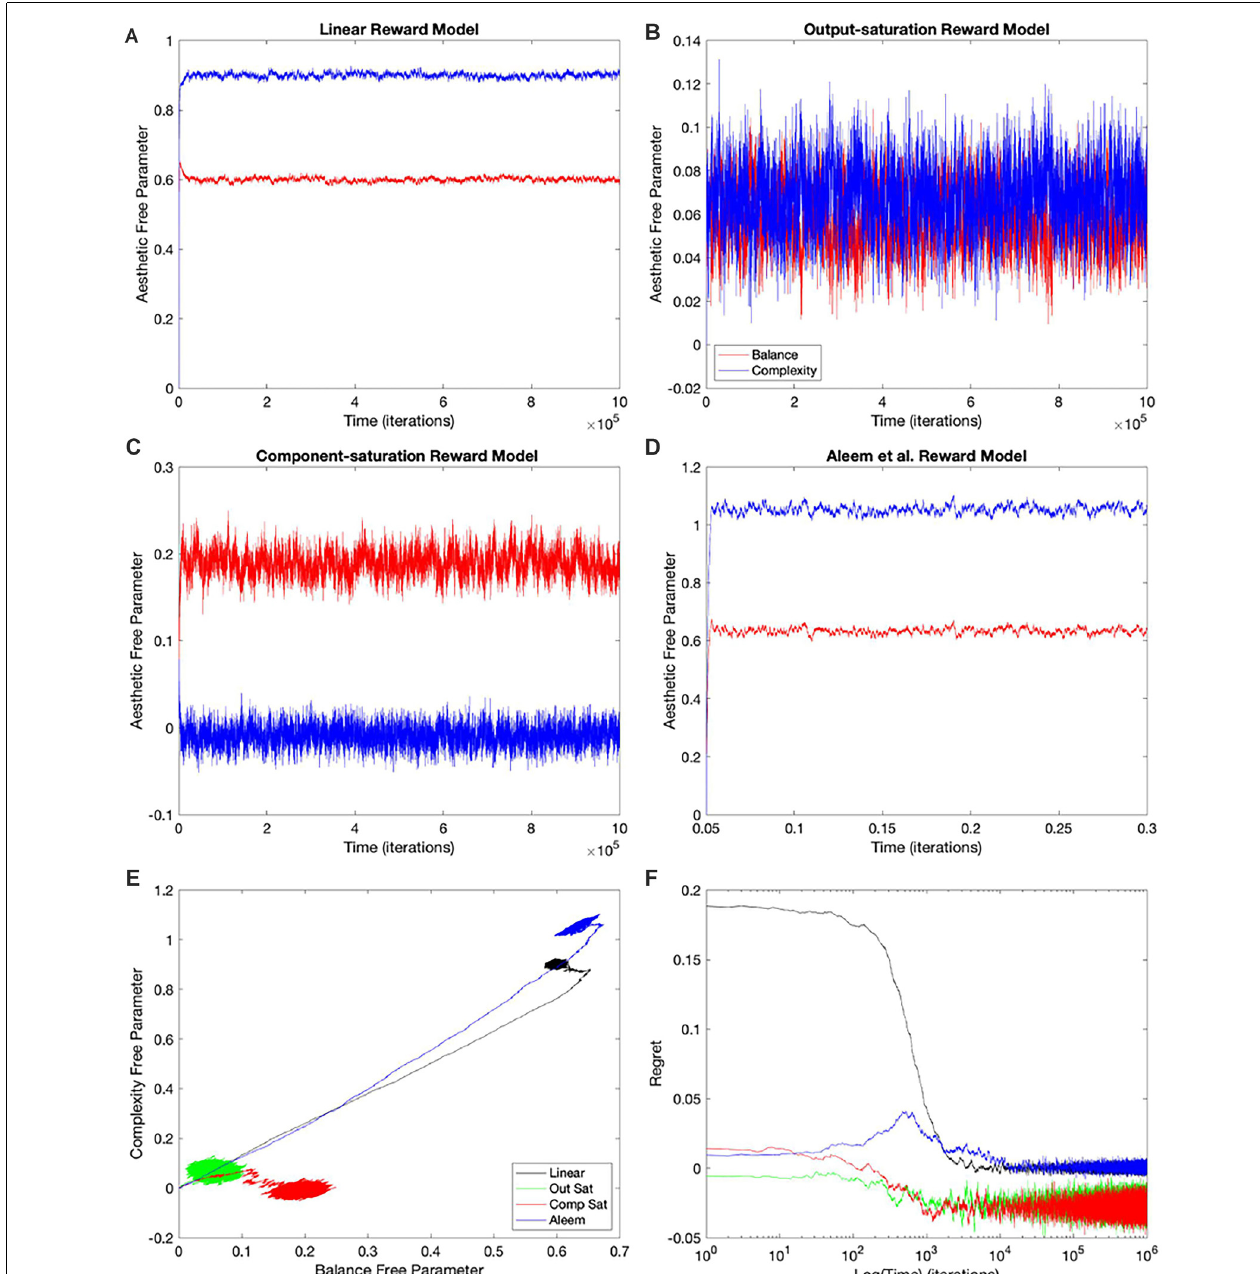
FIGURE 4 | Dynamics of the free parameters of the value function for the Mixed-linear conditions ( Table 1 ). The conventions for this figure are the same as those for Figure 2 . The results here are qualitatively like those in Figure 2 , but some significant quantitative differences are readily apparent. The panels and conventions for this figure are the same as those for Figure 2